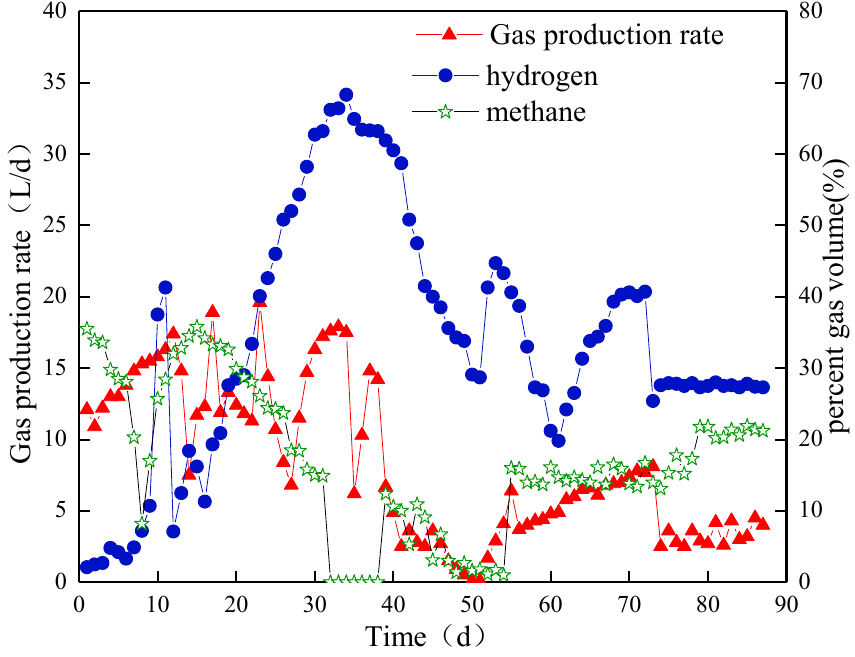
Figure 6. Biogas yield and content in Compartment III.